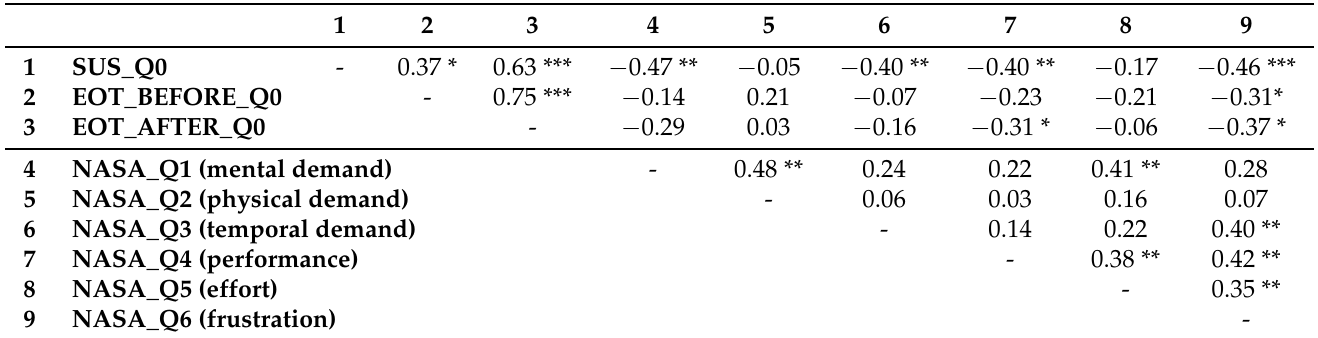
Table 4. Pearson correlations between system usability scale (SUS), expression of trust (EOT) and NASA TLX items.